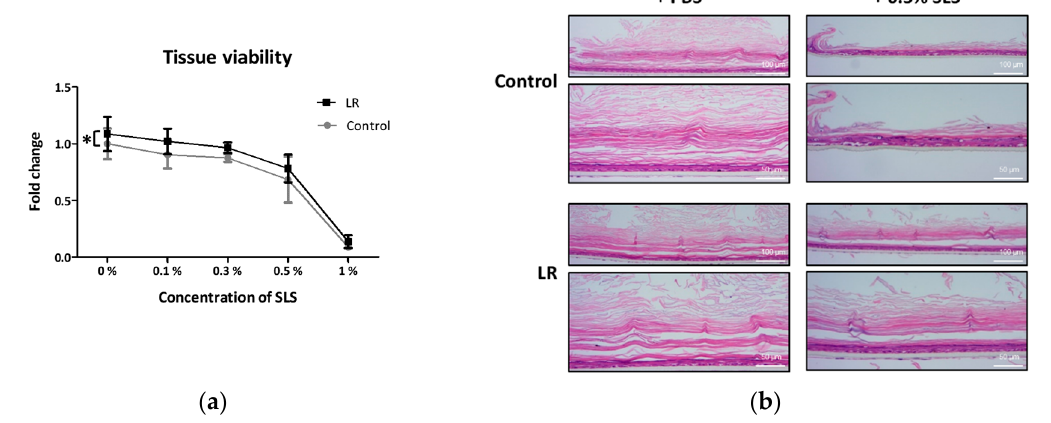
Figure 5. Attenuation of irritant-induced cytotoxicity by LR in Keraskin TM . Tissues were pretreated with LR for every other day 4 times and SLS was treated for 10 min. ( a ) Tissue viability was determined by the WST-1 assay. Results are expressed by the fold of control viability as mean ± SE of independent more than three tests and analyzed by two-way ANOVA. * p < 0.05 compared with PBS- treated control. ( b ) H&E stained tissues after with PBS or SLS treatment were measured by the light microscopy.